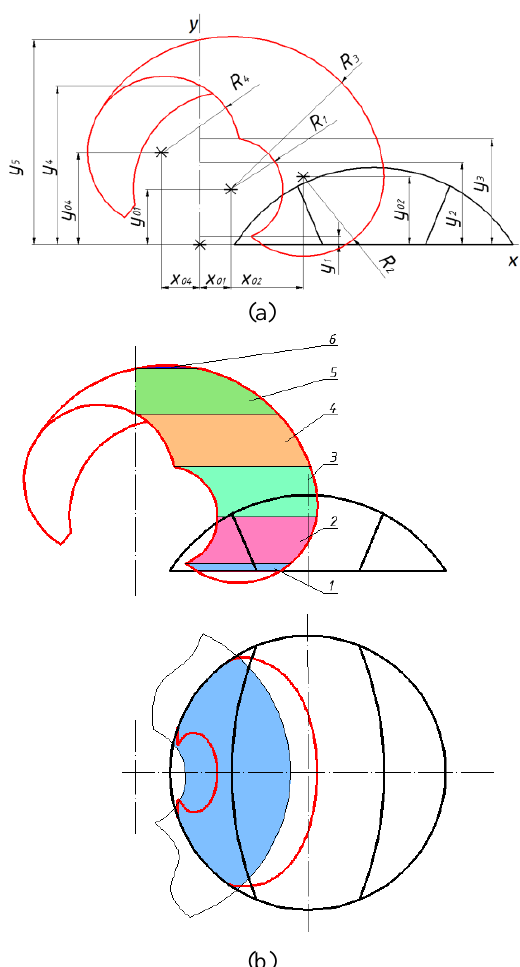
Fig. 8. Geometric interpretation of the mathematical model of obtaining a weld on the bottom with the help of an industrial robot: the profile of the bottom (a) and the layer-by-layer division of the working area of the robot